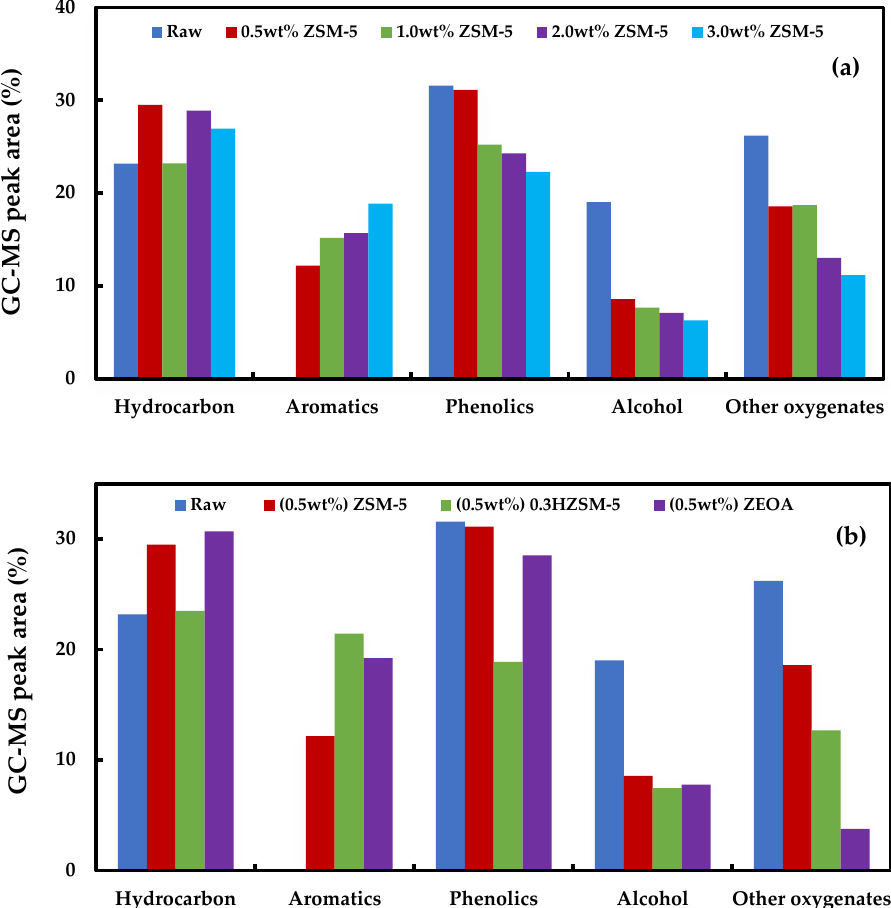
Figure 7. Groups of organic compounds detected in the bio-oil samples using GC-MS ( a ) ZSM-5 loading (0.5–3.0 wt %); ( b ) 0.5 wt % loading of ZSM-5, 0.3HZSM-5 and ZEOA.